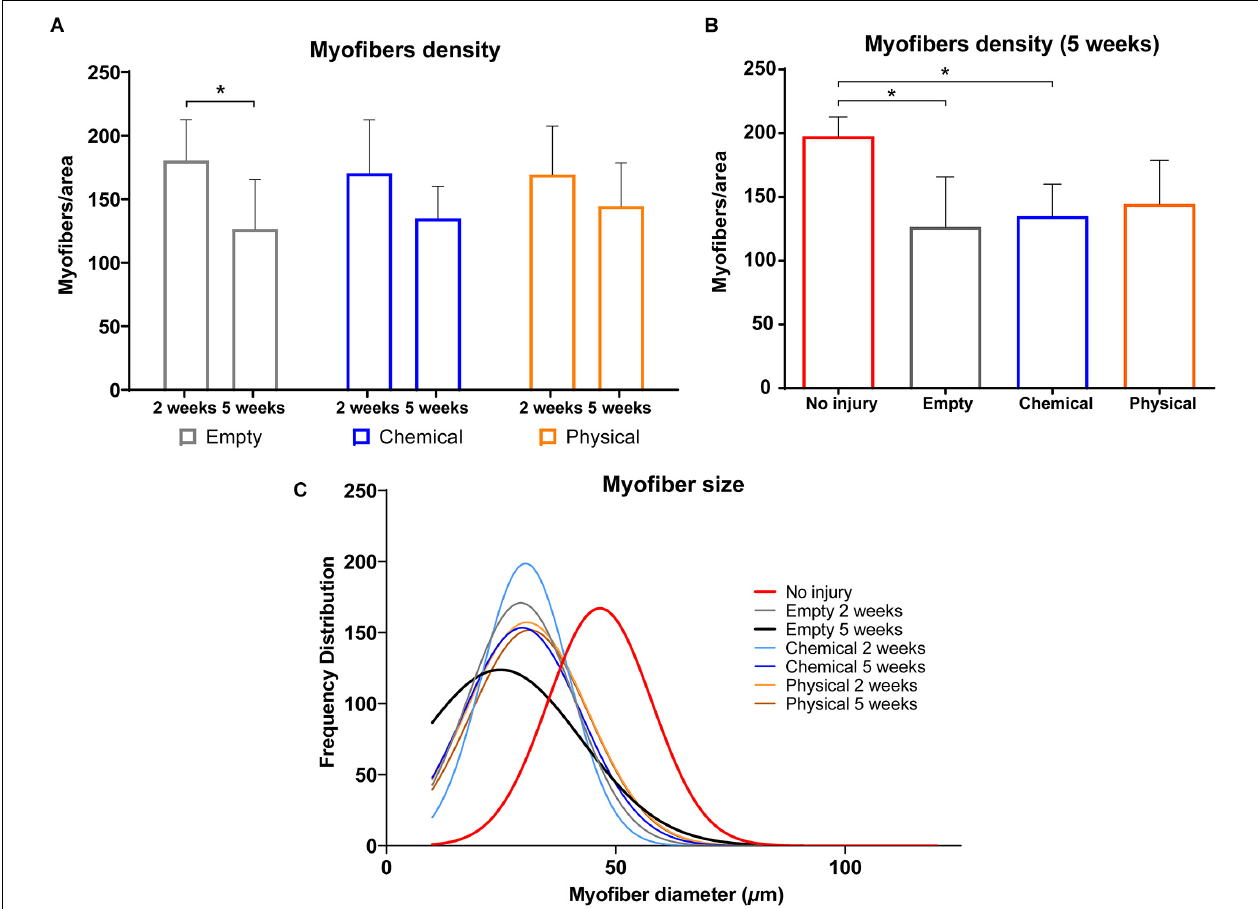
FIGURE 5 | Histomorphometric characterization of the HE-stained samples. (A) Myofiber density at 2 and 5 weeks post-injury for the empty (gray), chemical (blue) and physical (orange) groups. (B) Myofiber density after 5 weeks for the empty (gray), chemical (blue) and physical (orange) groups in comparison with no injury (healthy) samples (red). (C) Myofiber size distribution (number of myofibers with a specific diameter) for the different groups used in this study, i.e., empty, chemical, and physical, after 2 and 5 weeks, in comparison with the no injury (healthy) group. * p <